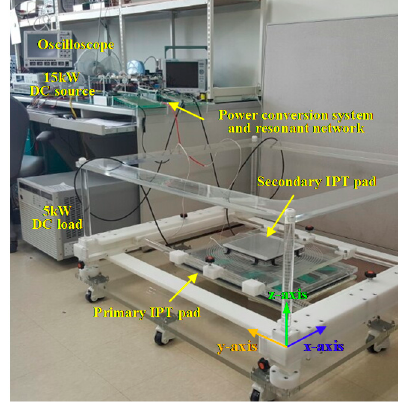
Figure 7. Laboratory prototype of the 3.3 kW IPT converter.